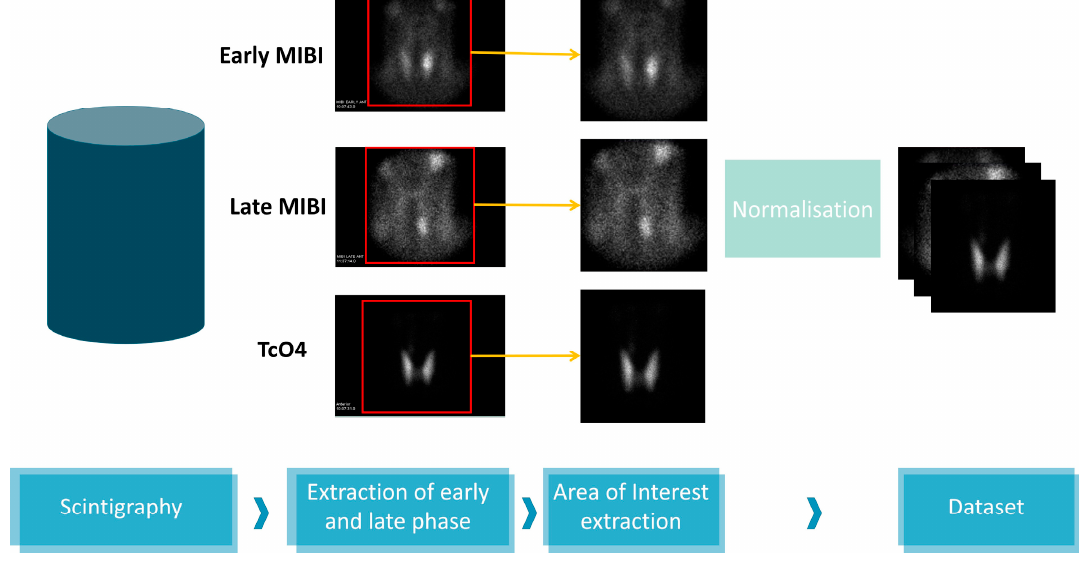
Figure 2. Data processing.